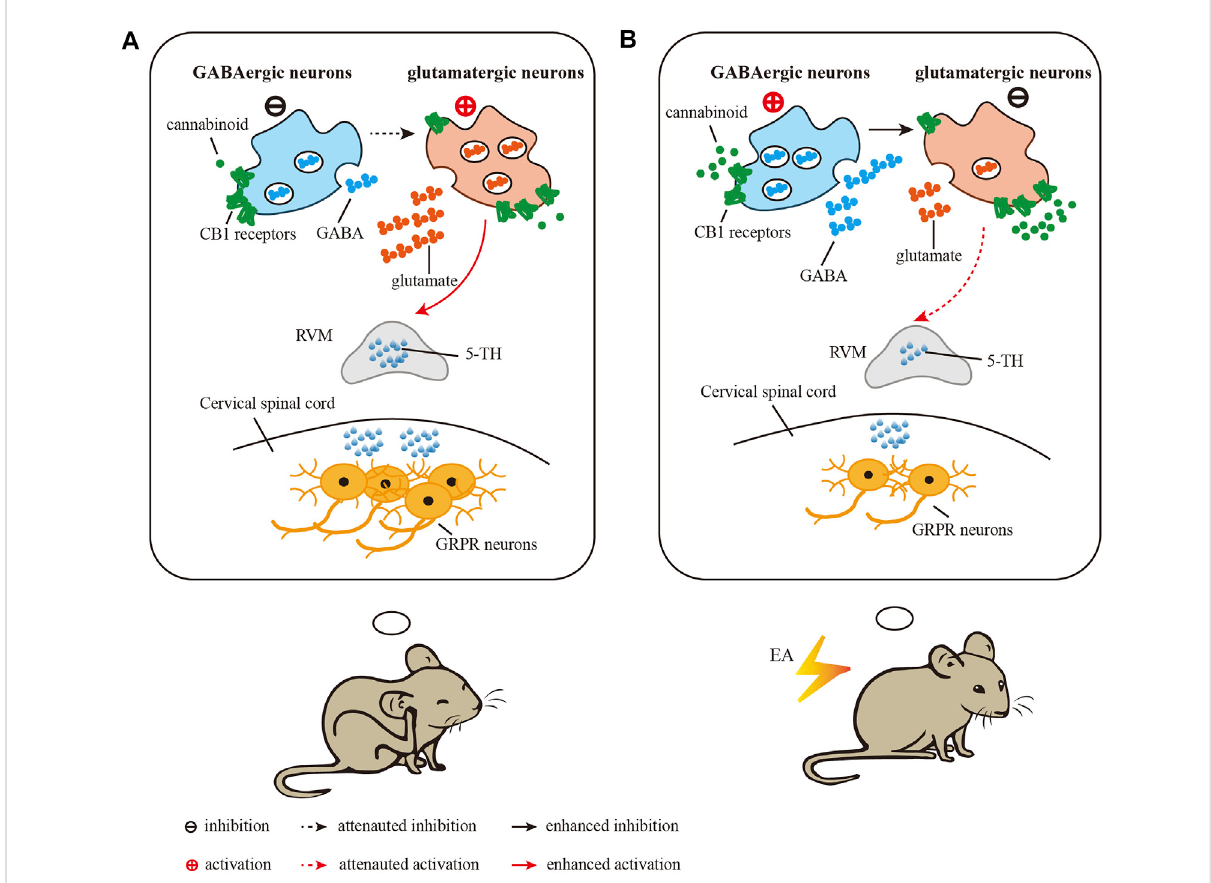
FIGURE 7 Diagram showing the role of CB1 receptorsin the vlPAG in the inhibitory effect of EA on chronic itch. (A) in the vlPAG after induction of chronic itch, glutamatergic neurons are activated and GABAergic neurons are inhibited, which activate RVM neurons to increase the level of 5-HT and the expression ofGRPRinthespinal cord. (B) EAtreatment resultsinactivationofGABAergicneuronstoinhibitglutamatergicneuronsinthevlPAG, thus attenuating the activation of RVM neurons and the level of 5-HT and the expression of GRPR in the spinal cord. EA promots the release of endogenous cannabinoids, which target CB1 receptors on glutamatergic terminals to inhibit neuronal activity. Through these two mechanisms, EA reduces the chronic